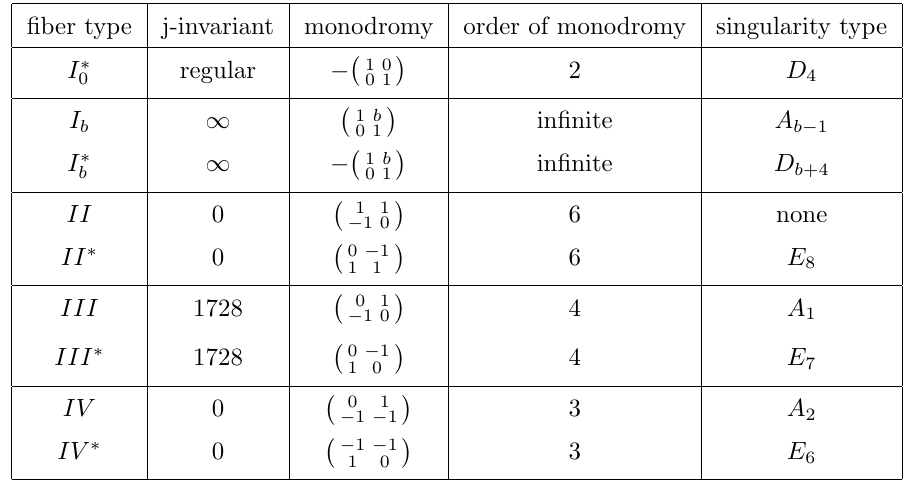
Table 1 . J-invariants, monodromies, and the corresponding singularity types of (cid:12)ber types. \Reg- ular" for type I (cid:3) means that the j-invariant of this (cid:12)ber type can take any (cid:12)nite value in C 0